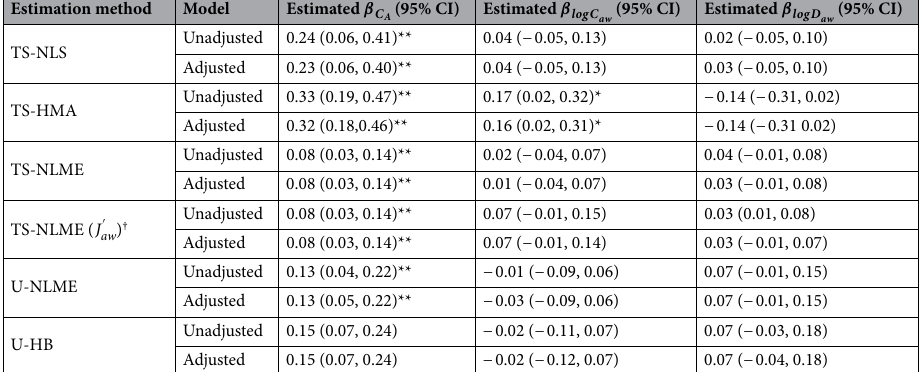
Table 2. Analysis of CHS data: estimated associations of a 10ppb increase in traffic-related air pollution β and 95% CI) using the selected methods, without and with adjustments for with C A , logC aw , and logD aw ( ′ covariates (age, sex, asthma). † Previously published model: J aw parameterization of TS-NLME. * P < 0.05, ** P < 0.01, *** P < (cid:31)